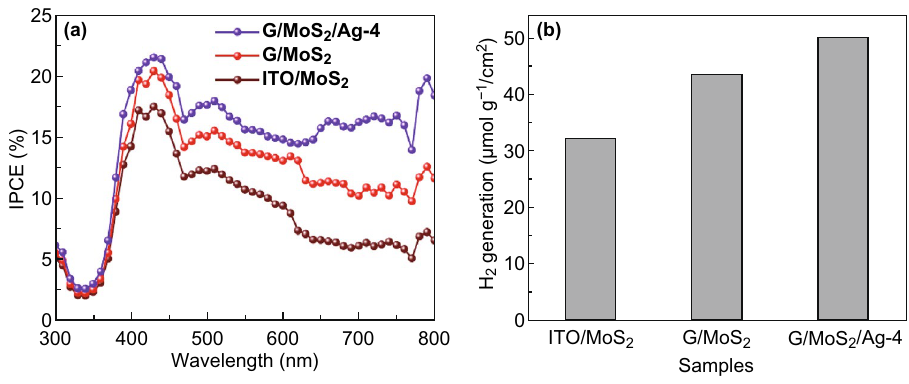
Fig. 9 a IPCE plots and b hydrogen evolution amounts for 15 min of PEC cells with various working electrodes (ITO/MoS 2 , G/MoS 2 , and G/ MoS 2 /Ag‑4) in 0.5 M Na 2 SO 3 + 0.5 M Na 2 SO 4